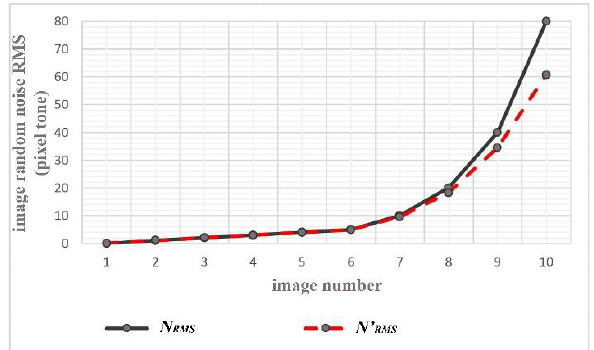
Figure 4. The graphs of the reference random image noise RMS ( N RMS ) for the test sample and random noise RMS, calculated by the harmonic analysis method ( Nʹ RMS